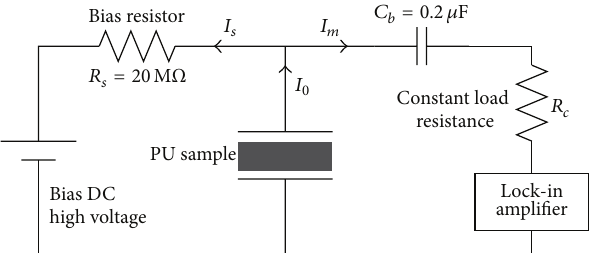
Figure 2: An electrical circuit connection of the power harvesting